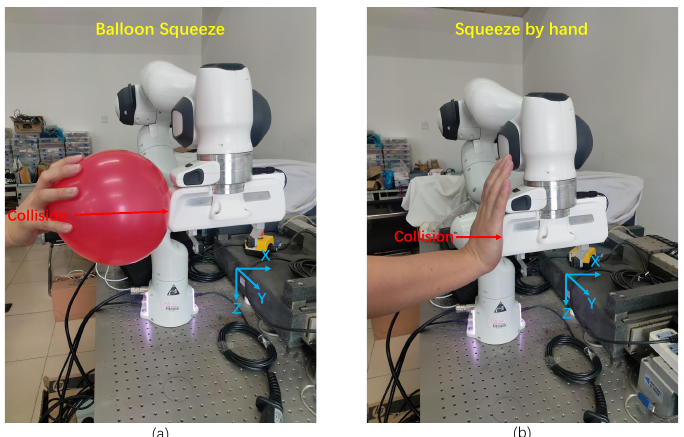
Figure 14. Quasi-static detection experiments: ( a ) Balloon squeezing; ( b ) Squeezing by hand.